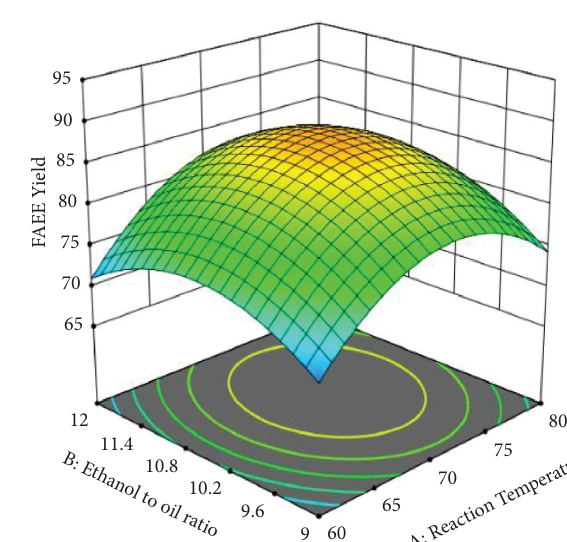
Figure 7: Te interaction impact of the reaction temperature and ethanol to oil ratio versus percentage yield of FAEE (own fgure).